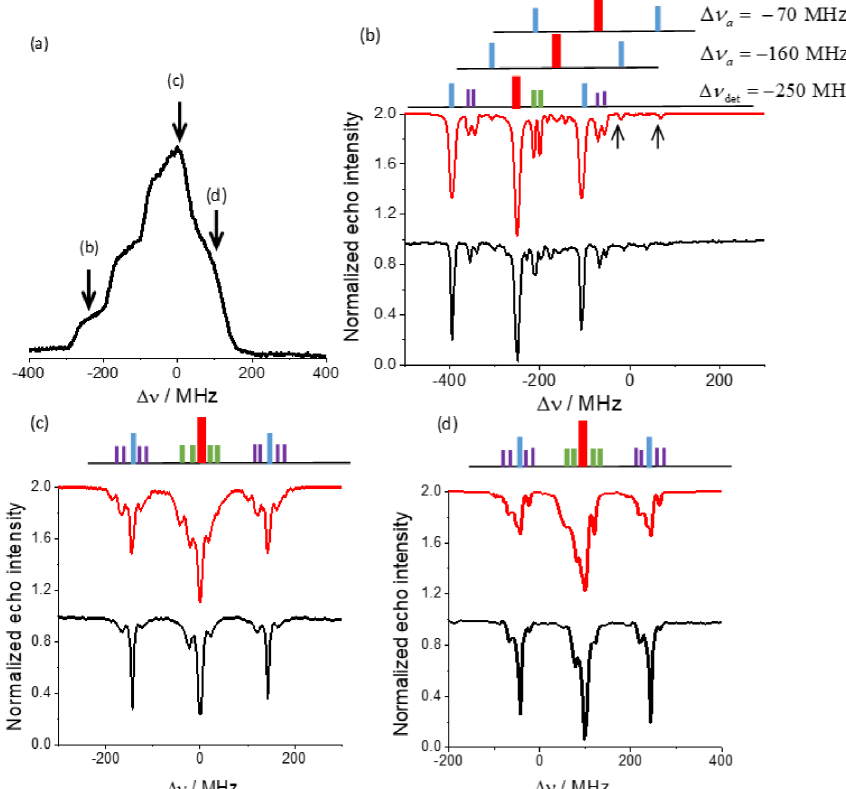
Figure 3. (a) The EPR spectrum and the positions at which the ELDOR spectra shown in (b–d) were recorded. (b–d) Experimental (black) and simulated (red) ELDOR spectra along with the associated stick spectrum using the color codes shown in Fig. 2, with detection frequencies ν det = 94 . 55, 94.8 and 94.9GHz, for (b) , (c) and (d) respectively. The frequency axis is plotted relative to the center of the EPR spectrum at 94.8GHz such that (cid:49)ν = ν MW − 94 . 8GHz. The (b) spectrum is the most resolved; it shows the 14 N DQ transitions as well as peaks due to the other four allowed transitions and their associated 1 H forbidden transitions (indicated by arrows) arising from off-resonance and relaxation effects. A schematic for the different transitions in this case are described by the stick diagram, with (cid:49)ν a the positions of the two pairs of allowed transitions. Experiments were performed at